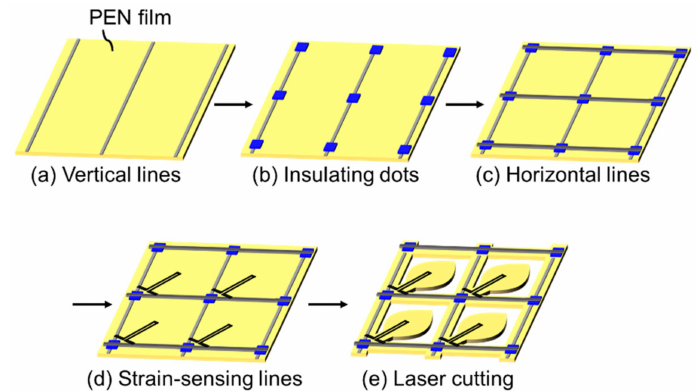
Figure 1. Process flow for fabricating the wind pressure distribution sensor. ( a ) Screen printing Ag paste to form vertical lines. ( b ) Screen printing UV-curable resist to form insulating dots. ( c ) Screen printing Ag paste to form horizontal lines. ( d ) Screen printing strain-sensing lines. ( e ) Laser cutting to form suspended structures.